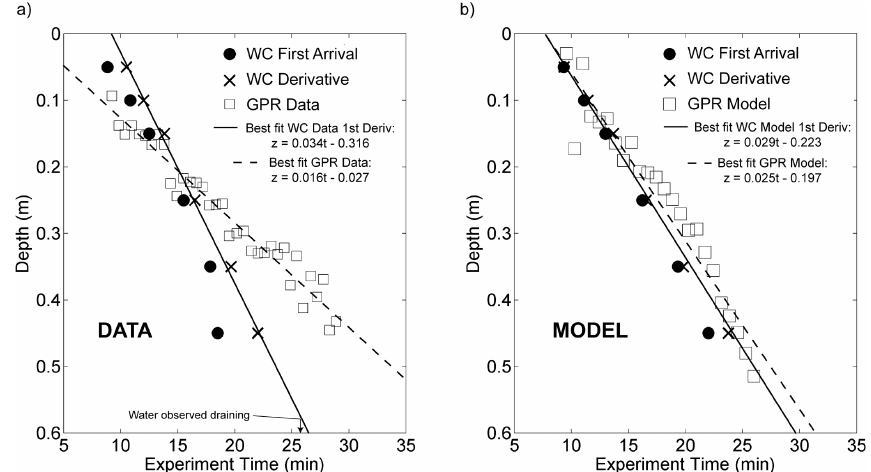
Fig. 3. Estimated depth to the wetting front based on water content probe and GPR measurements for (a) experimental and (b) simulated data. Arrival of the wetting front based on probe measurements was calculated using the first arrival of water and the maximum temporal derivative of the water content in the probe record. Water was observed draining from the tank at 26min (indicated by the